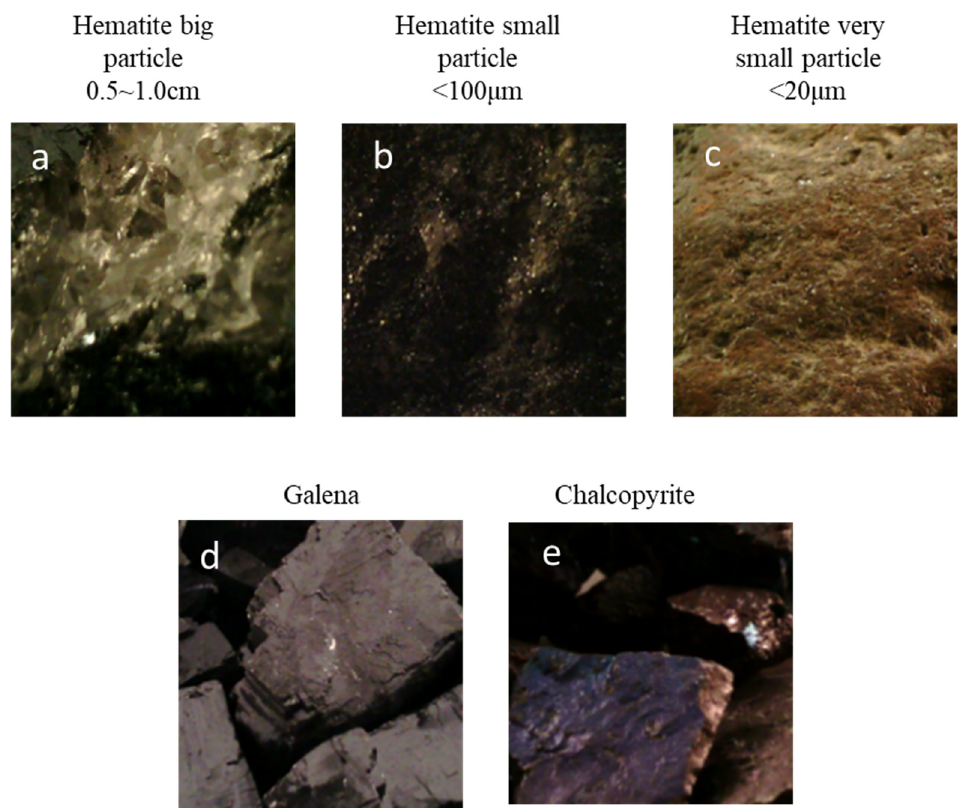
Figure 5. Five types of minerals for classification: ( a ) hematite large particles, ( b ) hematite small particles, ( c ) hematite very small particles, ( d ) galena, and ( e ) chalcopyrite.